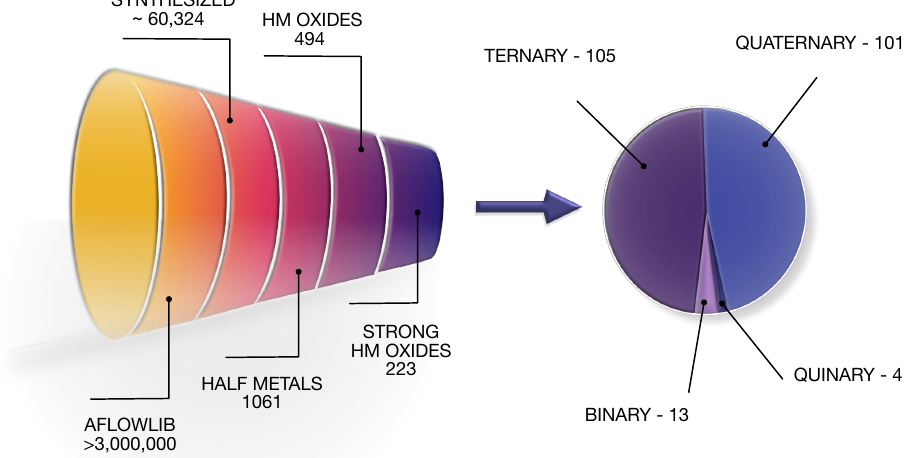
Figure 1. Left: Scheme illustrating steps of the high-throughput (HT) search for half-metallic oxides starting with the AFLOWLIB database. Right: Diagram representing the distribution of different structural groups among the identified half-metal